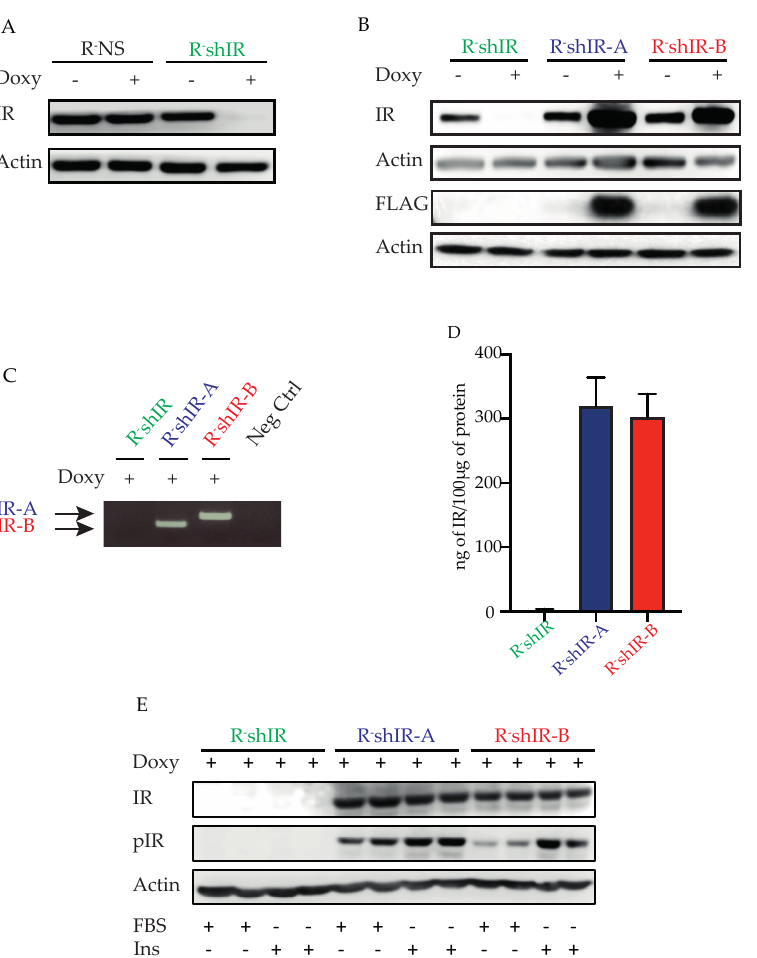
Figure 1. Generated cell lines: insulin receptor silencing and selective IR-A and IR-B expression. ( A , B ): R-NS (control cells expressing non-silencing shRNA for the IR), R-shIR (cells silenced for the IR), R-shIR-A (expressing only the human IR isoform A) and R-shIR-B (expressing only the human IR isoform B) were obtained from R-cells (cells deprived of the IGF-1 receptor and expressing only the endogenous murine IR at low levels) by transfection with the respective doxyciclyne- inducible vectors. ( C ): RT-PCR showing the selective expression of hIR-A or hIR-B in the indicated cell lines. Neg control indicates the PCR reaction missing of cDNA. ( D ): The human IR β solid-phase sandwich ELISA was used to measure the amount of insulin receptor in each experimental condition. Histograms represent the residual endogenous receptor and the quantity of selectively expressed IR- A or IR-B in R-shIR, R-shIR-A and R-shIR-B cell lines. Bars indicate the standard deviation from two independent experiments. ( E ): Immunoblot showing the IR-A and IR-B isoforms phosphorylation in the indicate experimental conditions. Actin (Act) was used as loading